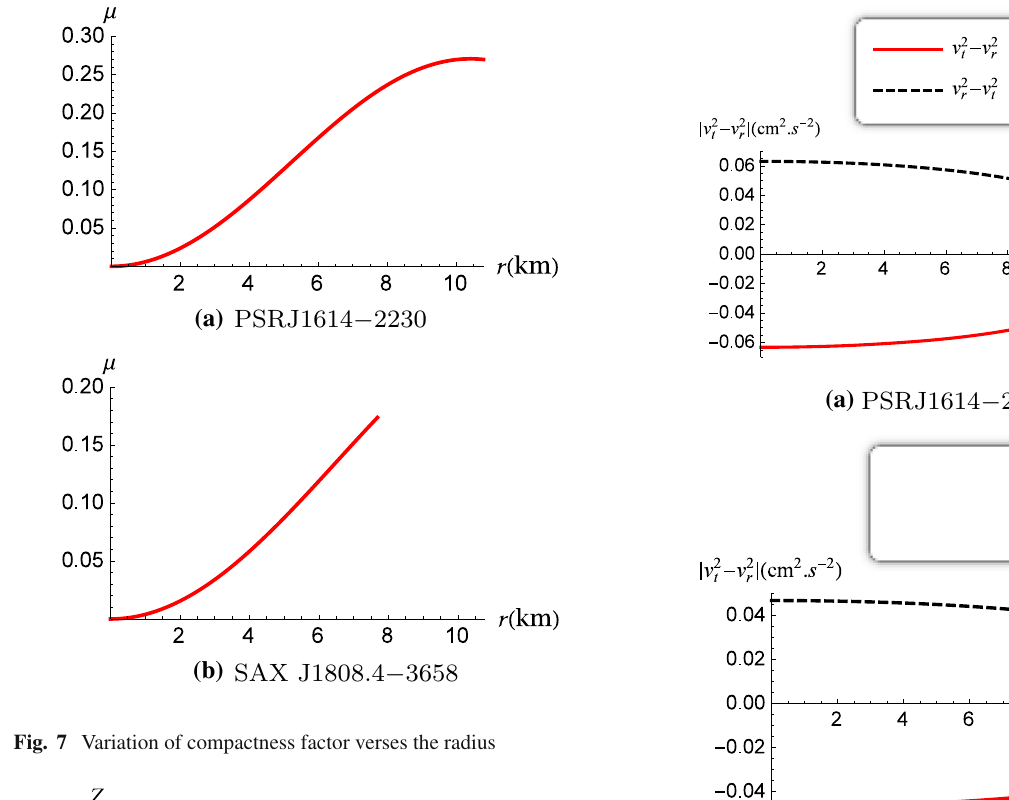
positive, decreasing continuously inside the star. The